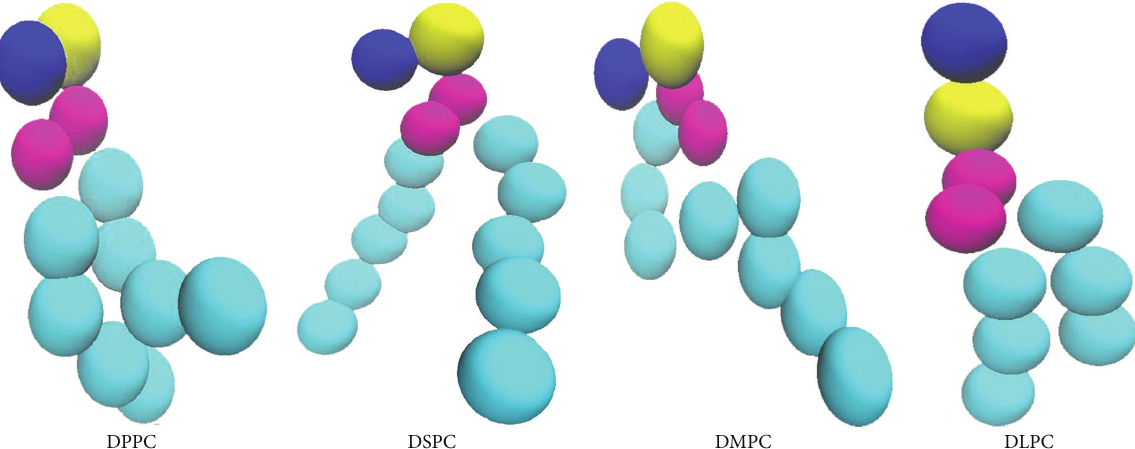
Figure 2: The DPPC, DSPC, DMPC, and DLPC molecular structures after